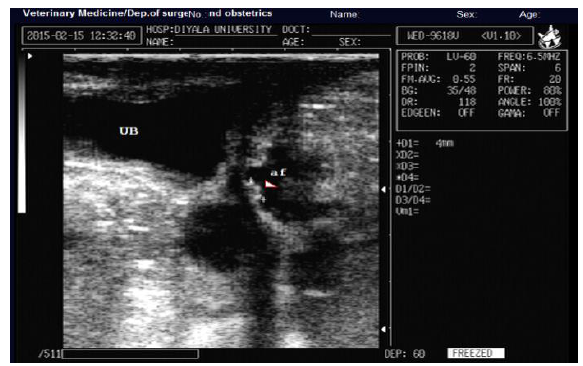
Figure, 2: Trans-rectal Ultrasonic images of 35day of pregnancy, Placentome: Arrowhead; u.b; urinary bladder; a.f: allantois fluid.